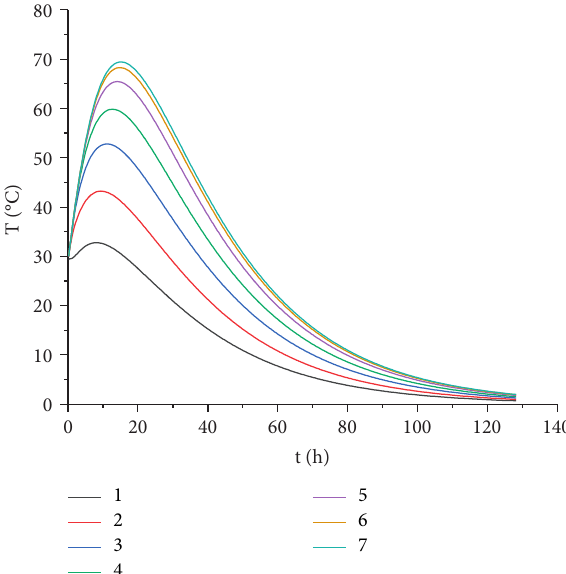
D for different CFST Figure 12: Temperature curves of concrete at different locations.